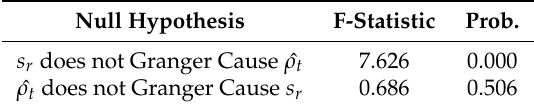
Table A5. The results of the pairwise Granger causality.